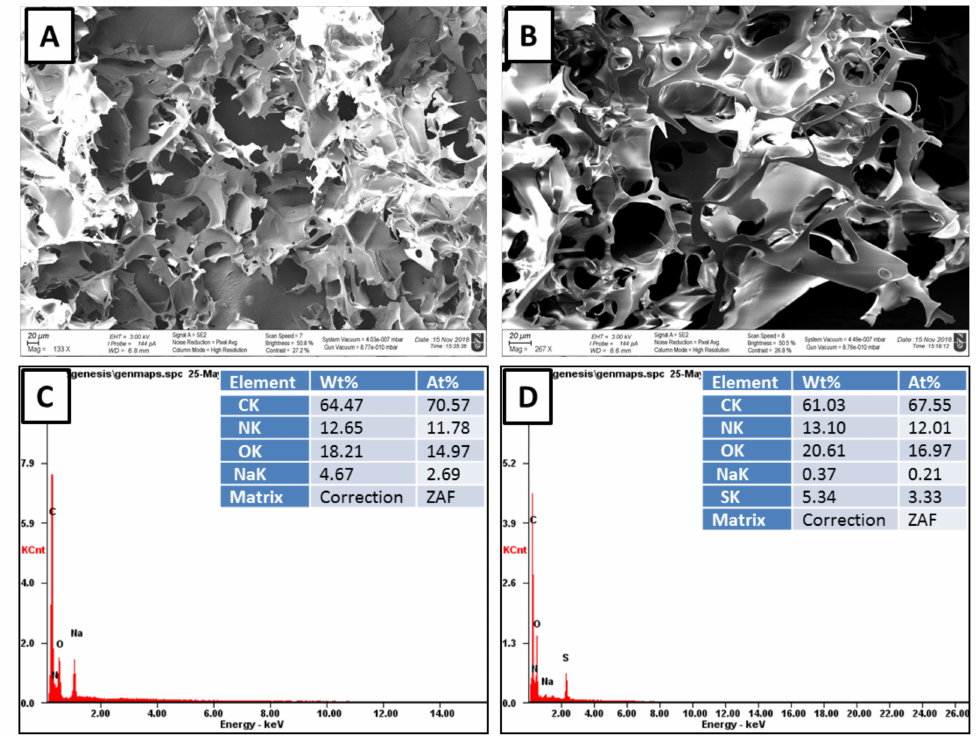
Figure 2. SEM and elemental composition according to point EDX analysis of ( A , C ) the p(MAAc)- DMAAm-AA and ( B , D ) p(AMPS)-DMAAm-AA